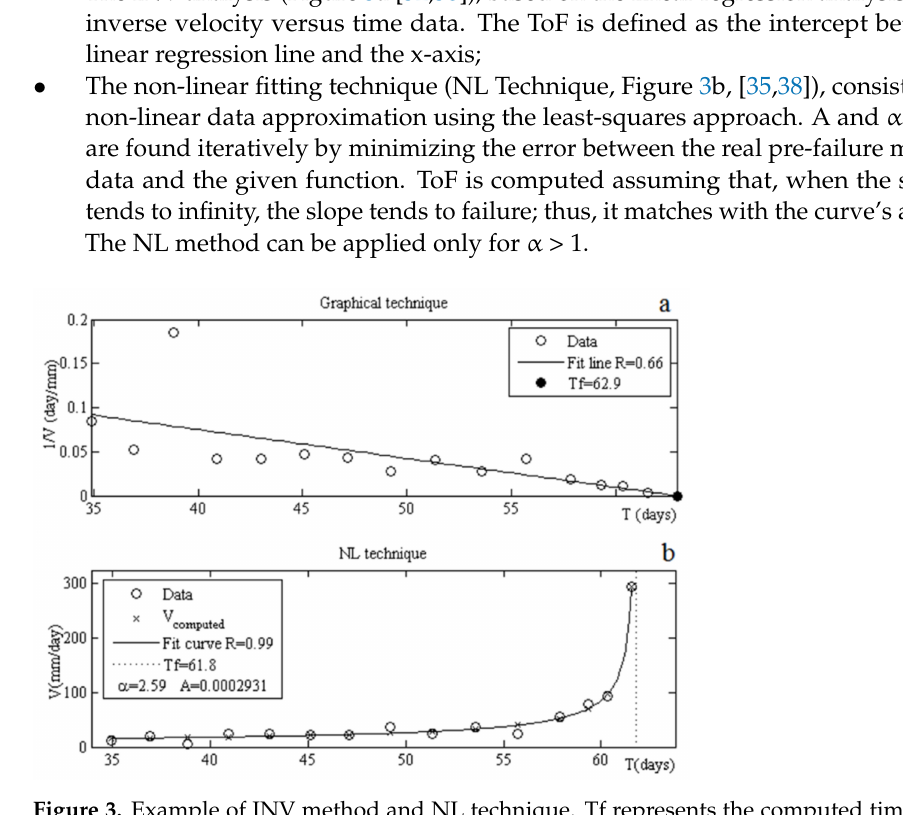
Figure 3. Example of INV method and NL technique. Tf represents the computed time of failure (from [39],